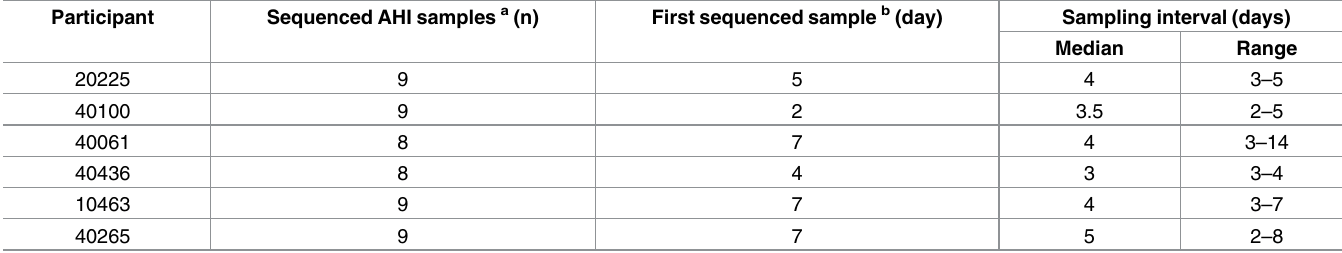
Table 3. Early and frequent sampling during acute HIV-1 infection (AHI) in 6 participants from RV217.